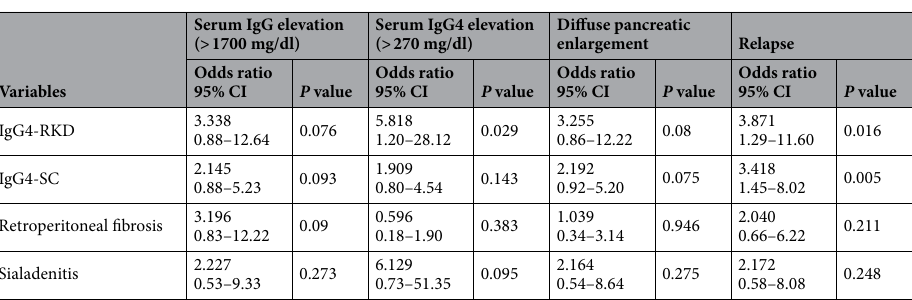
Table 3. Multivariate analyses for clinical features and relapse rate. IgG4-SC IgG4-related sclerosing cholangitis, IgG4-RKD IgG4-related kidney disease, CI confidence interval.